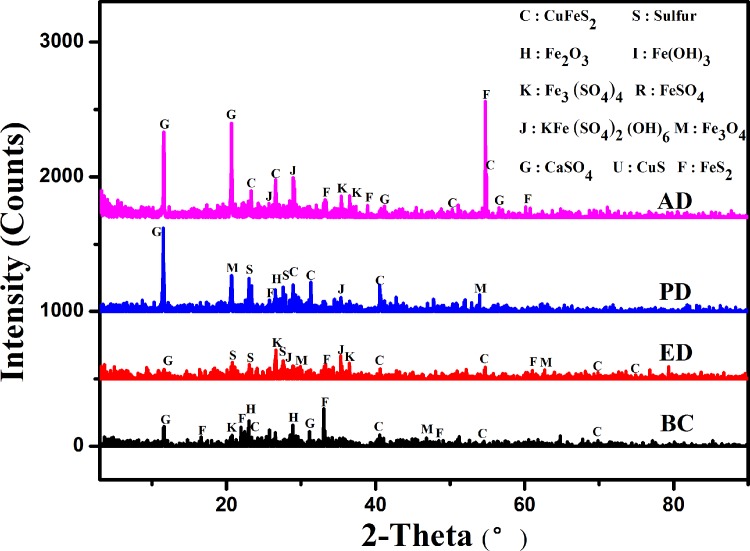
XRD analysis of the ore samples in different bioleaching systems.C:CuFeS2; S:Sulfur; H: Fe2O3; I: Fe(OH)3; K: Fe3(SO4) 4; R: FeSO44; J: KFe3(SO4)2(OH)6; M: H: Fe3O4.